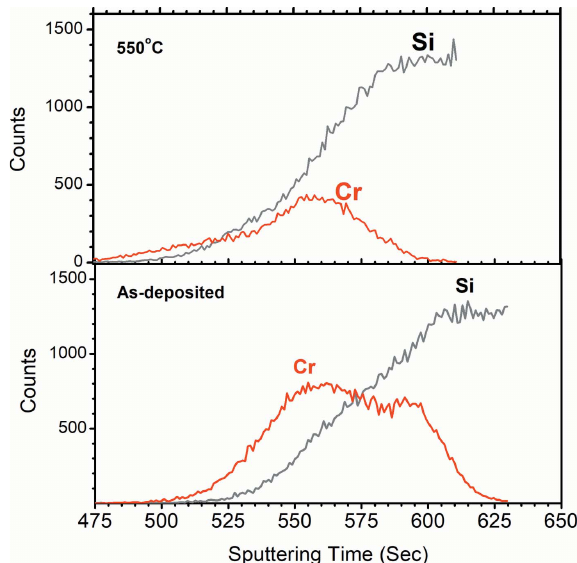
Figure 7 Cr and Si distributions in the bilayer sample as obtained as a function of sputtering time from SIMS measurement. Only the Cr–SiO 2 region is shown.